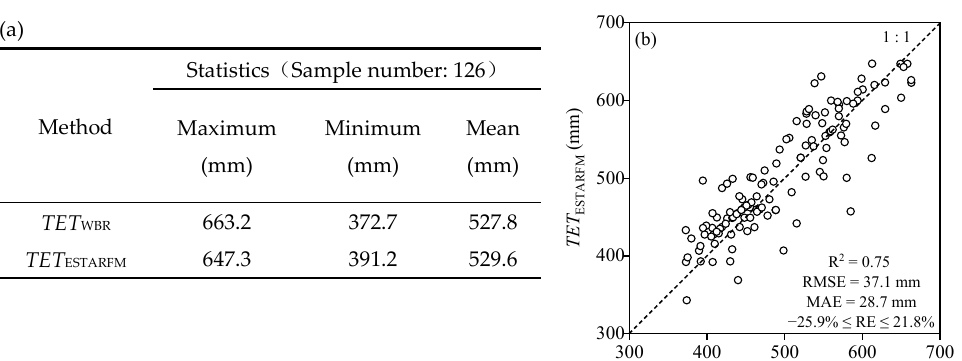
Figure 7. Comparisons of the annual total evapotranspiration between TET WBR measured at regional scale and TET ESTARFM fused by ESTARFM in cotton fields under film-mulched drip irrigation in the Manas River Basin from 2000 to 2020: ( a ) Table for the statistical characteristics of measured TET WBR and fused TET ESTARFM ; and ( b ) 1:1 diagram (R 2 : coefficient of determination; RMSE: root-mean- square error; RE: relative error; MAE: mean absolute error).